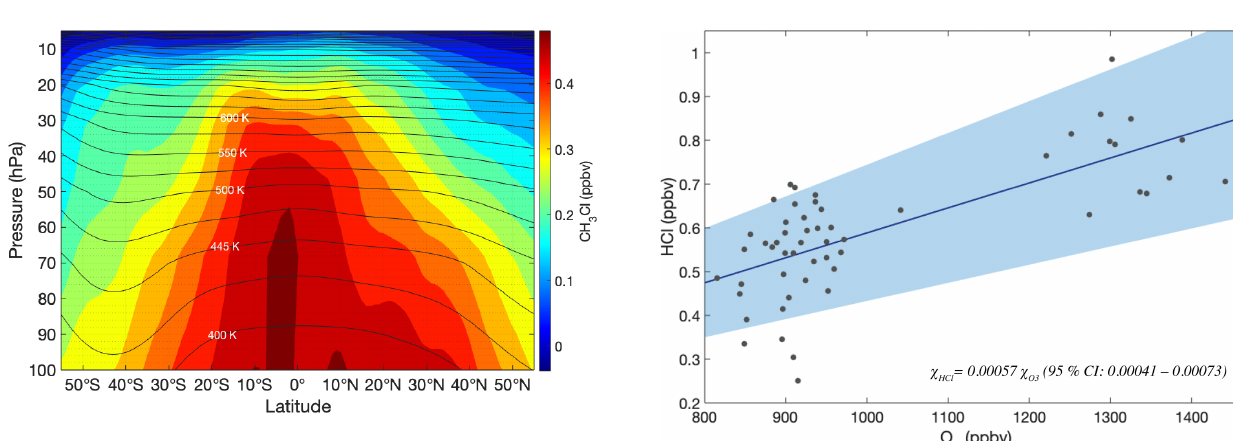
Figure 15. Same conditions as for Fig. 13 except the profile illus- trated is CH 3 Cl. Note that CH 3 Cl has a strong latitude dependence but inverse to the trend seen in HCl.